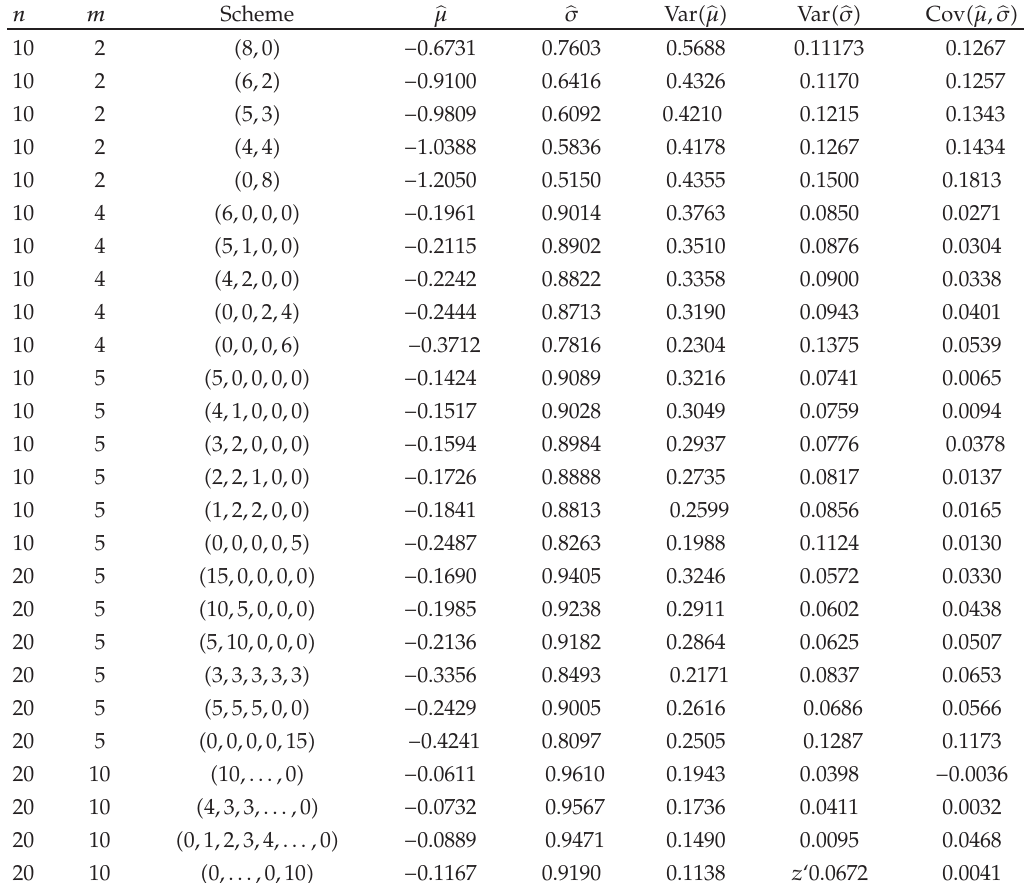
Table 4: Average, variances, and covariance of the MLEs when the shape parameter φ (cid:7) 1 .